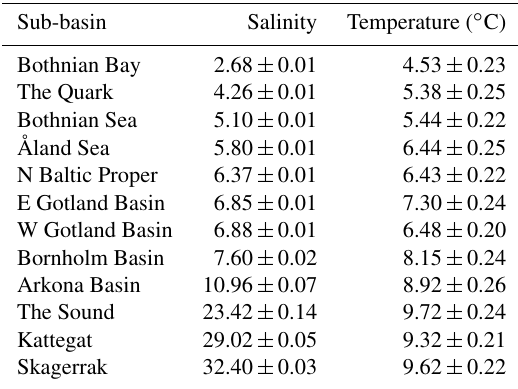
Table 1. Salinity and temperature in Swedish coastal areas, given as mean ( ± SE) annual values per sub-basin across the years 1993– 2019. Values represent conditions near the bottom at 0–30m depth based on data from the EU Copernicus Marine Service Information (CMEMS,